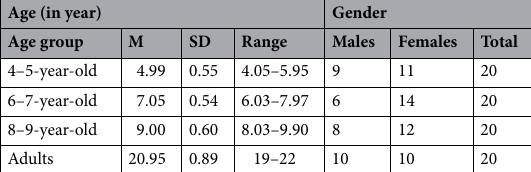
Table 1. Age and gender distribution of each age